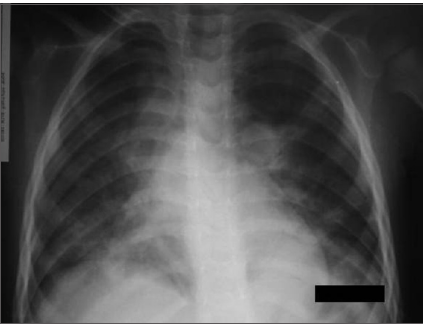
Figure 1. Chest X-Ray during respiratory dysfunction, showing the bilateral interstitial